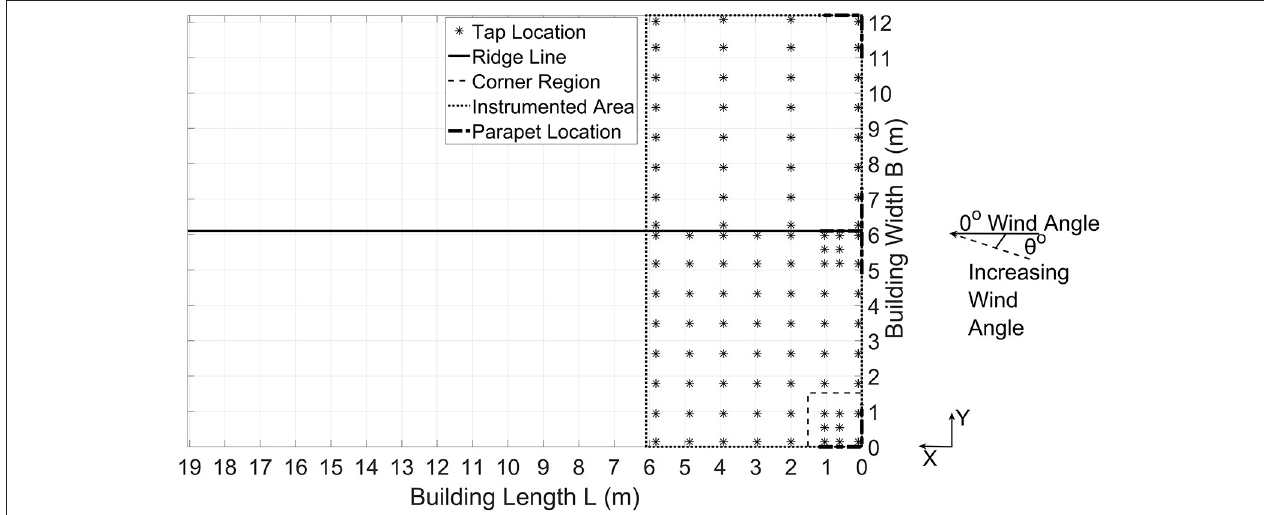
FIGURE 5 | Tap layout, wind direction, and location of parapets on the